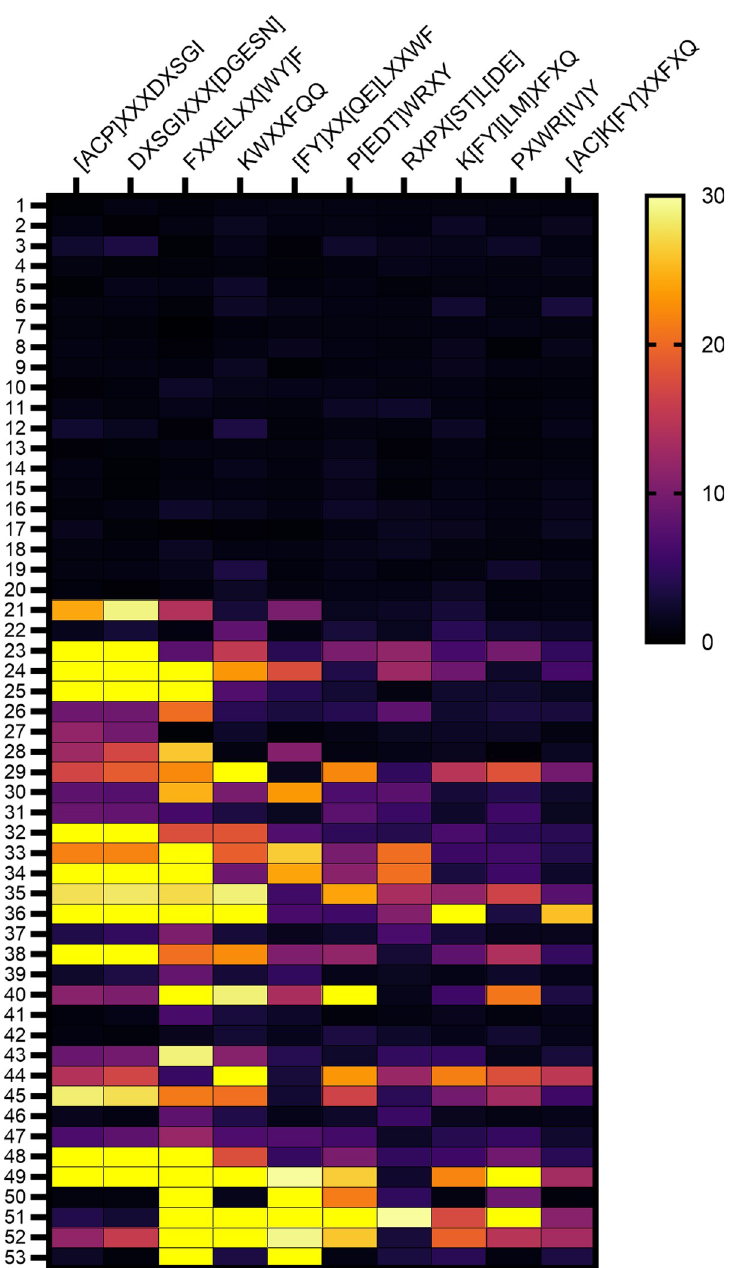
Fig 1. Heat map identifying amino acid motifs preferentially recognized by IgG from vaccinated subjects. Amino acid motifs were identified among the peptides immunoprecipitated by IgG from vaccine recipients using IMUNE algorithm and the level of enrichment (fold increase) in serum of individual subjects relative to pre-pandemic control subjects is depicted in the heat map. Samples 1–20 are pre-vaccine and samples 21–40 are the same subjects after Pfizer-BioNTech COVID-19 mRNA vaccination. Subjects 41–48 are from subjects that received Moderna vaccine. Samples 49–53 are vaccinated subjects that previously had COVID-19. https://doi.org/10.1371/journal.pone.0252849.g001 for (A) N = 20 subjects without prior COVID-19 before Pfizer-BioNTech immunization, (B) the same N = 20 subjects without prior COVID-19 after immunization with the Pfizer-BioN- Tech COVID-19 vaccine, (C) N = 8 subjects without prior COVID-19 after immunization